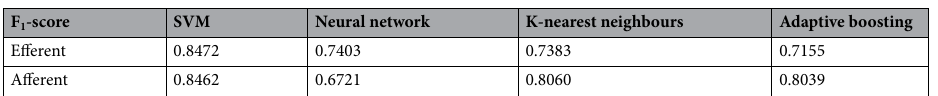
Table 1. Summarizes the F 1 - score for different algorithms applied to the 2-class problem (efferent and afferent) using Model 1.